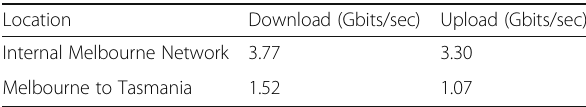
Table 4 Comparison of network speed (TCP) Location